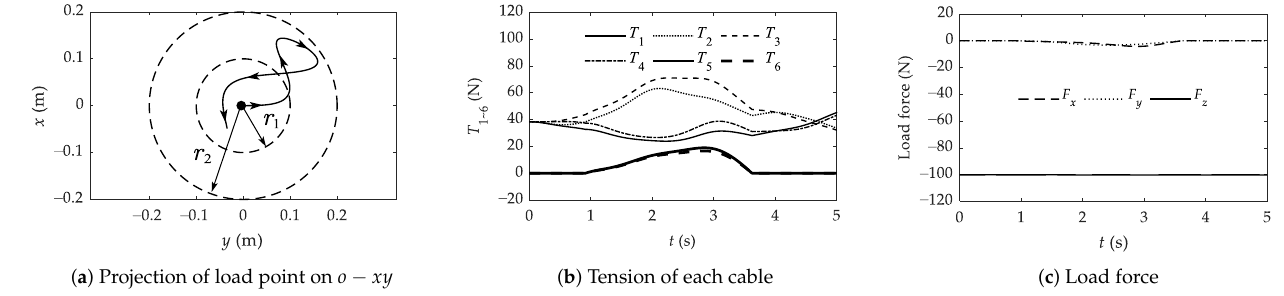
Figure 11. Simulation results. ( a ) projection of load point on the o - xy plane; ( b ) tension of each cable; ( c ) load